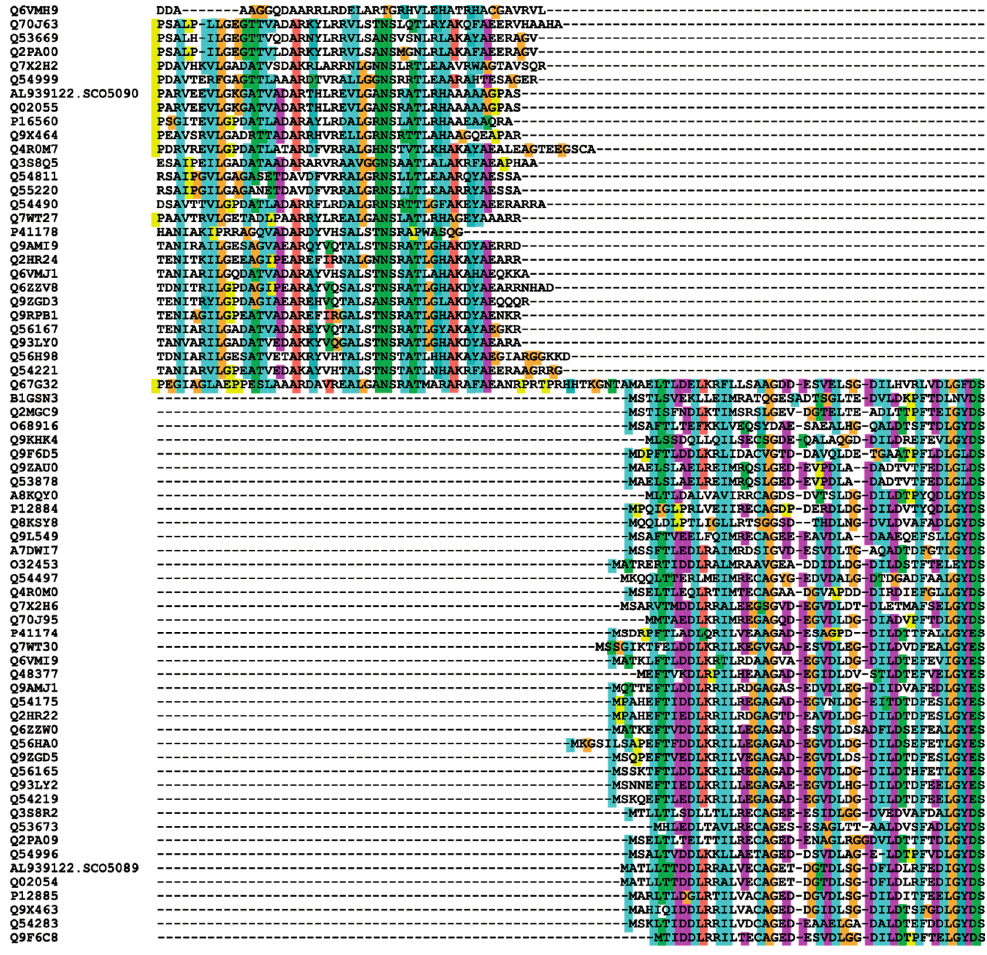
Figure 2. Section of alignments of clique 2 and 3 to C1. Clique 3 includes the first 27 sequences which clearly align to the N -terminus of C1, shown here as Q67G32. Clique 2 includes the last 40 sequences that align to the C -terminus of C1. Figure taken from section of result shown on Seaview.